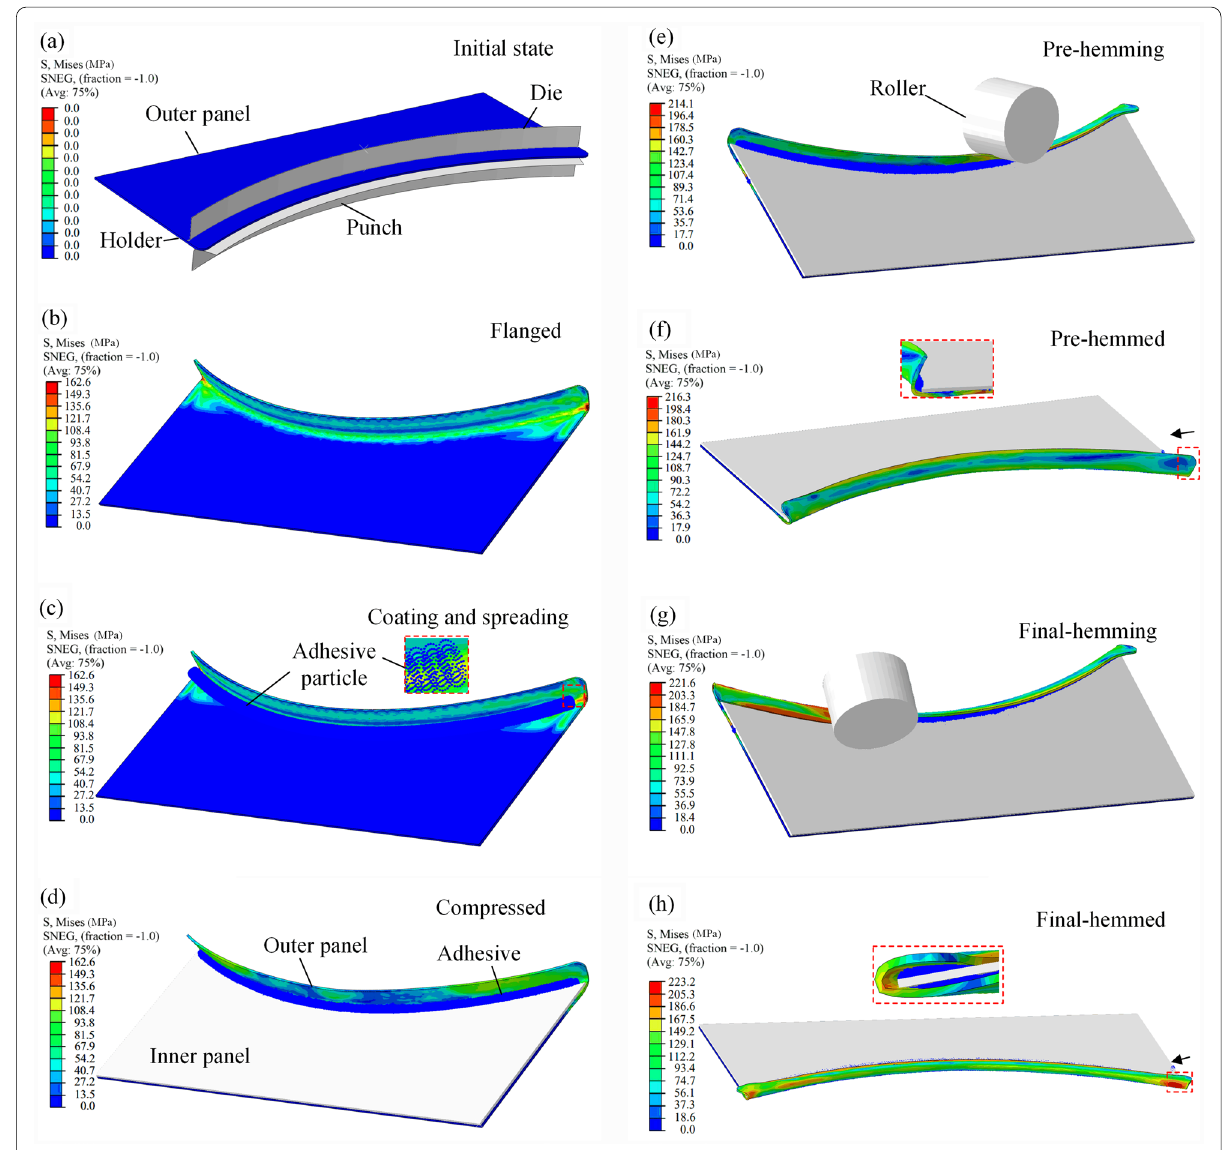
Figure 7 Roller hemming process of concave edge panels with